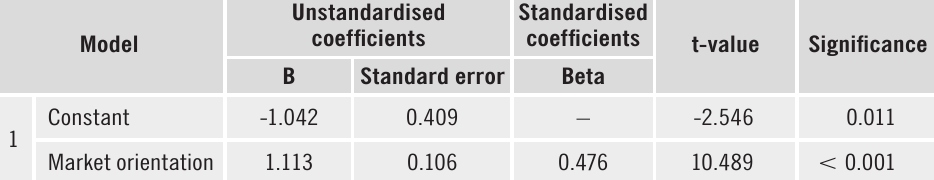
Table 14. Coefficients: level of market orientation and competitiveness index